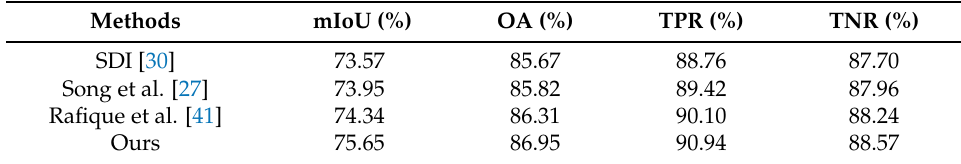
Table 7. Weakly supervised results on validation set of mapping challenge dataset. These methods are all box-based and only have bounding boxes annotations in the training